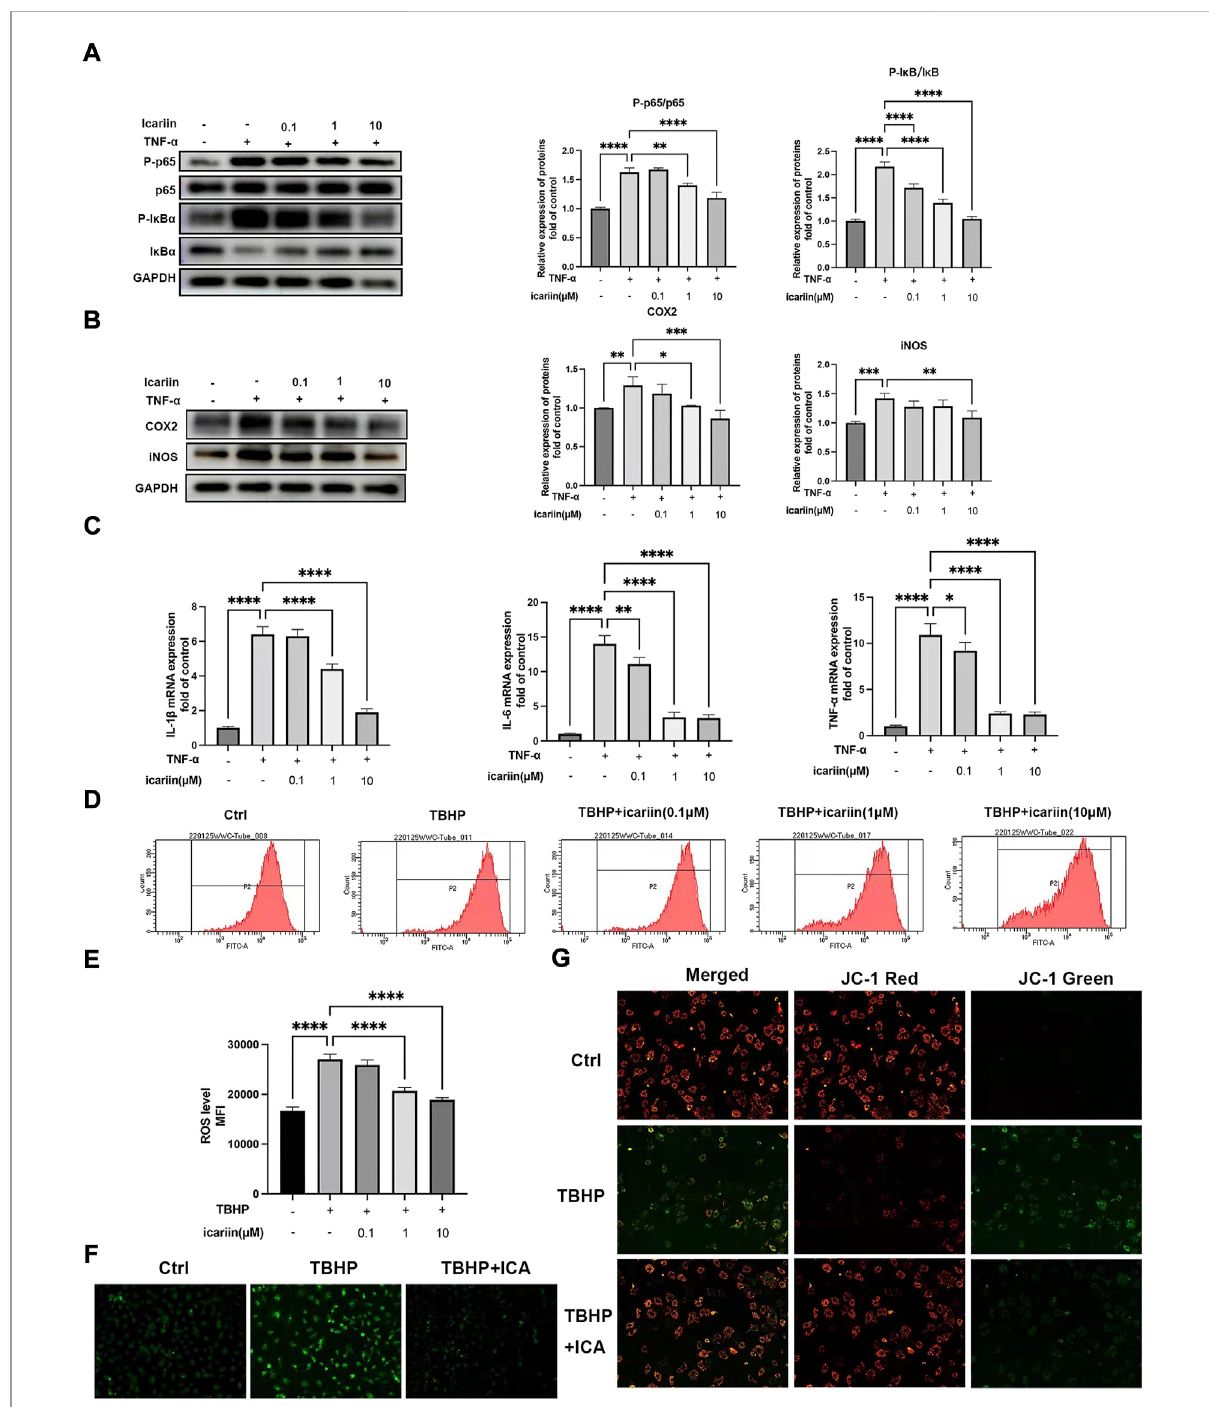
FIGURE 4 ICA suppressed TNF- α and TBHP-induced in fl ammatory response, oxidative stress, and mitochondrial dysfunction. (A) Chondrocytes were treatedwithTNF- α (5 ng/ml)andICA(0.1,1,and10 μ M)for24 h,andWesternblotwasconductedtoexaminetheproteinlevelsofP-p65,p65,P-I κ B, and I κ B. The ratio of P-p65/p65 and P-I κ B/I κ B was quanti fi ed and normalized to control. (B) Chondrocytes were treated with TNF- α (5 ng/ml) and ICA (0.1, 1, and 10 μ M) for 24 h, and Western blot was conducted to examine the protein levels of COX2 and iNOS. The band densities of COX2 and iNOS were quanti fi ed and normalized to control. (C) RT-PCR was used to detect the expression of cytokines including IL-1 β , IL-6, and TNF α . (D – E) Intracellular ROS levels in the endplate chondrocytes were detected using the DCFH-DA and measured by fl ow cytometry. (F) Representative fl uorescence microscopy photomicrographs of intracellular ROS in endplate chondrocytes. Green fl uorescence indicates the intracellular ROS production. (G) Representative fl uorescence microscopy photomicrographs of mitochondrial membrane potential (MMP) after